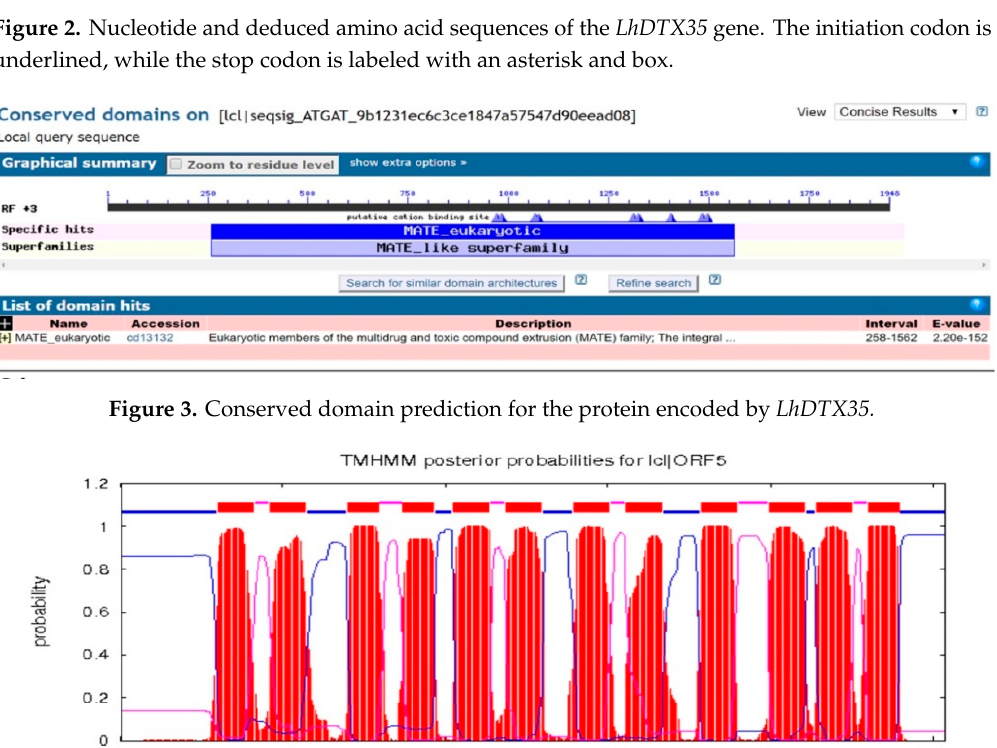
Figure 4. Transmembrane prediction for the protein encoded by LhDTX35.